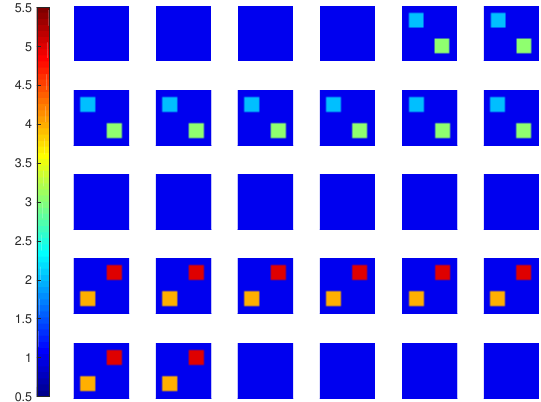
Figure 7. True permittivity profile (real part) for Example 2